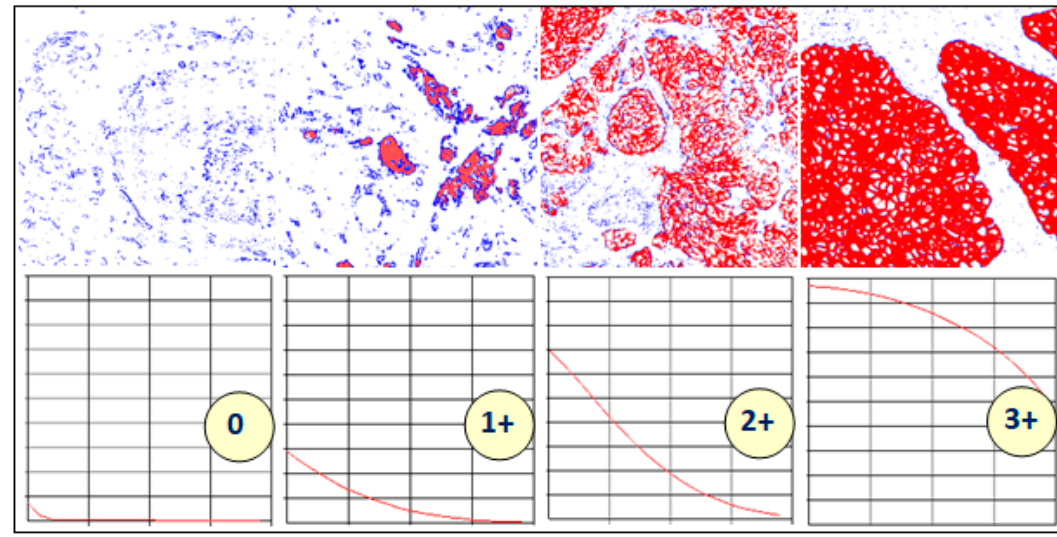
Figure 4. Variations in the shapes of the characteristic curves with different levels of staining. Reproduced from [12] with permission.